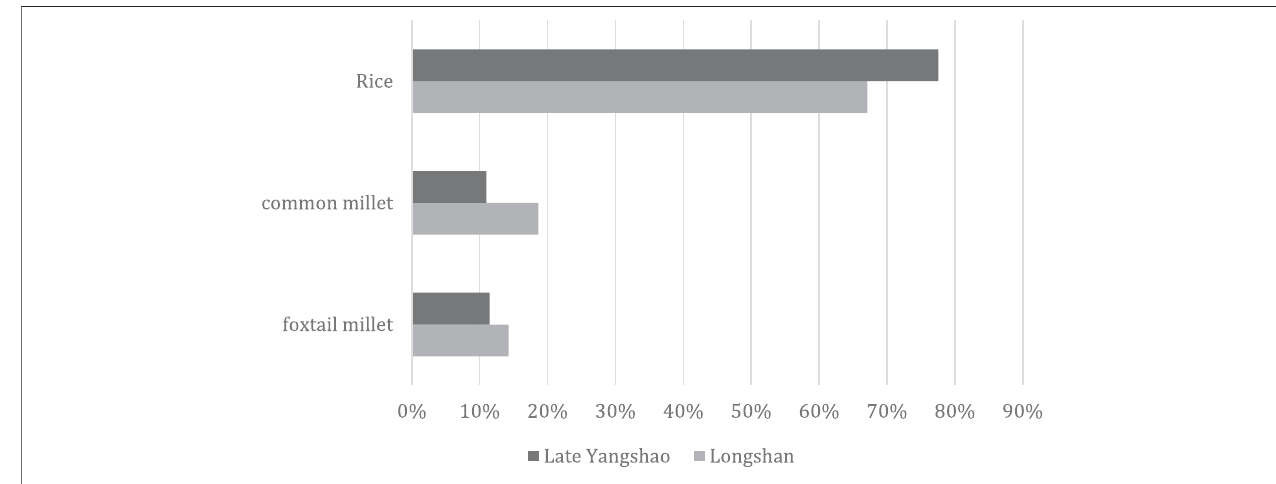
FIGURE 5 | Proportions of glume phytoliths of common millet, foxtail millet, and rice at the Suyang site.